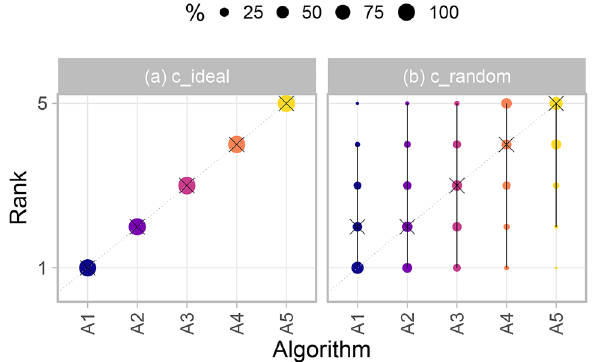
Figure 5. Blob plots for visualizing ranking stability based on bootstrap sampling. Algorithms are color coded, and the area of each blob at position (cid:31) A i , rank j (cid:30) is proportional to the relative frequency A i achieved rank j (here across b = 1000 bootstrap samples). The median rank for each algorithm is indicated by a black cross. 95% bootstrap intervals across bootstrap samples (ranging from the 2.5th to the 97.5th percentile of the bootstrap distribution) are indicated by black lines.